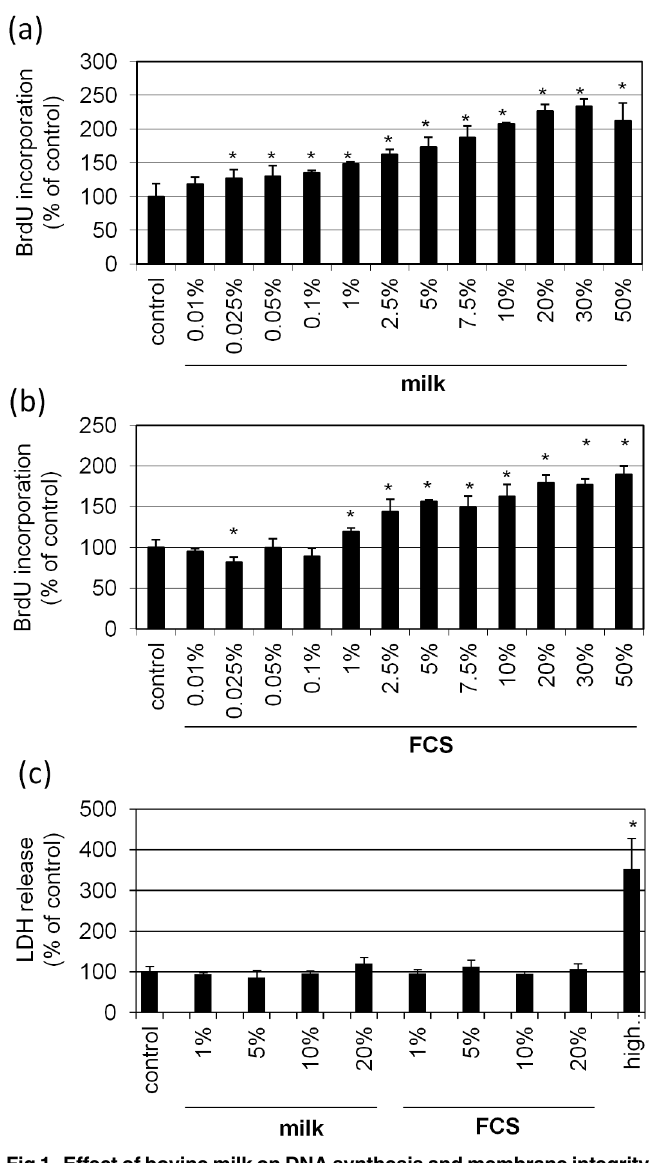
Fig 1. Effect of bovine milk on DNA synthesis and membrane integrity. Normal human skin fibroblasts were cultured in medium supplemented with increasing concentrations of (a) bovine milk or (b) FCS for control. After 24 hours the incorporation of BrdU in the DNA was determined. Likewise, the liberation of LDH as a marker of membrane integrity was determined after incubation with (c) bovine milk or FCS. Complete release of LDH was achieved by treatment with 1% Triton X-100 (high control). Each bar represents the mean of 4 independent experiments. Standard deviations are indicated. Data were compared to untreated controls. * p <